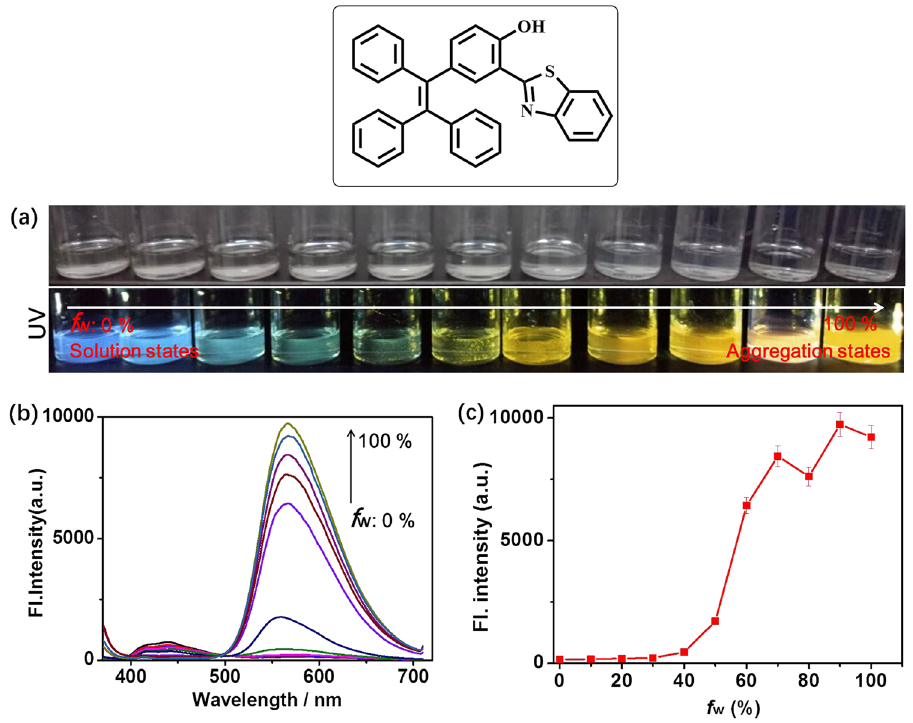
Figure 5. ( a ) Photographs of TPE-TLE-O in water/DMF mixtures taken under nature light and UV illumination; ( b ) Fluorescence spectra of TPE-TLE-O in water/DMF mixture; ( c ) Plots of maximum emission intensity of TPE-TLE-O in water/DMF mixtures with different f w values. [ TPE-TLE ] = 5.0 μ M. λ ex = 365 nm. The error bars represent standard deviation ( ±